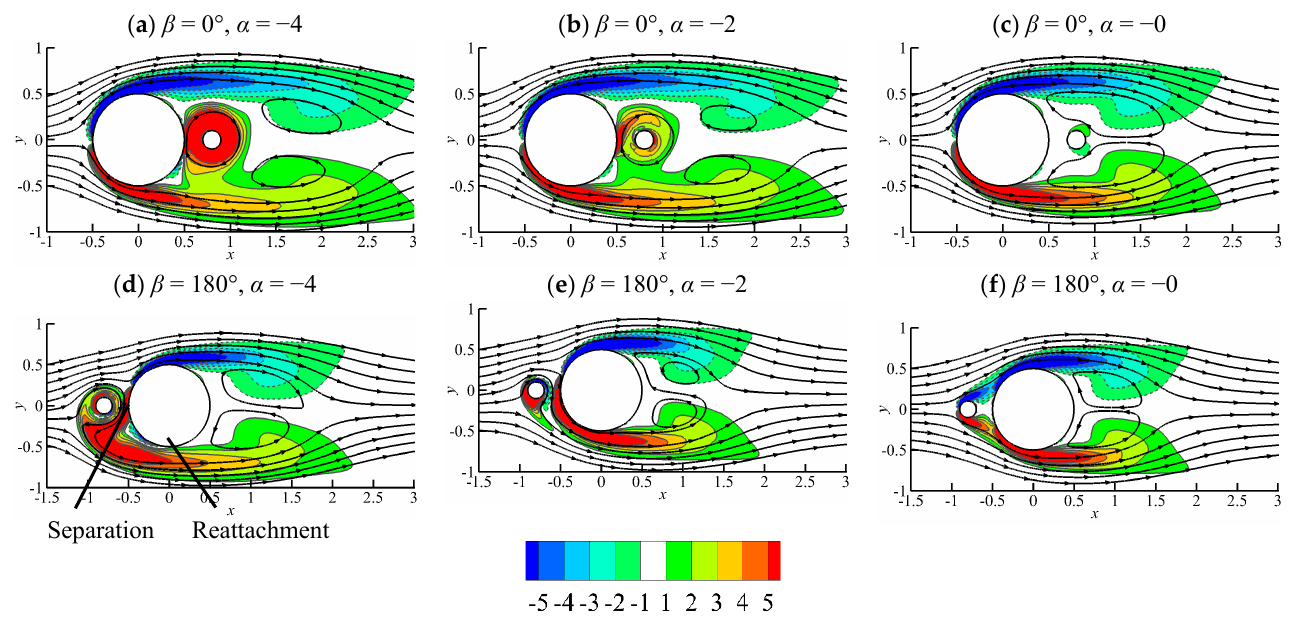
Figure 8. Streamlines and the contours of the nondimensional vorticity of the mean flow for β = 0° and 180°.